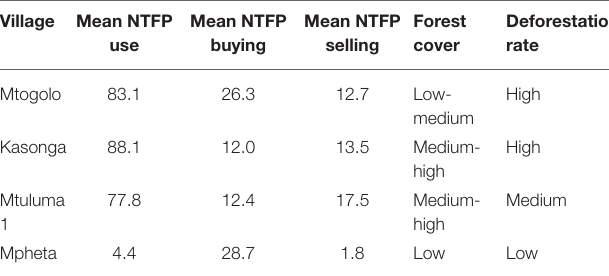
TABLE 9 | Comparison of mean use, buying, and selling of NTFPs across the study villages in relation to forest cover and deforestation